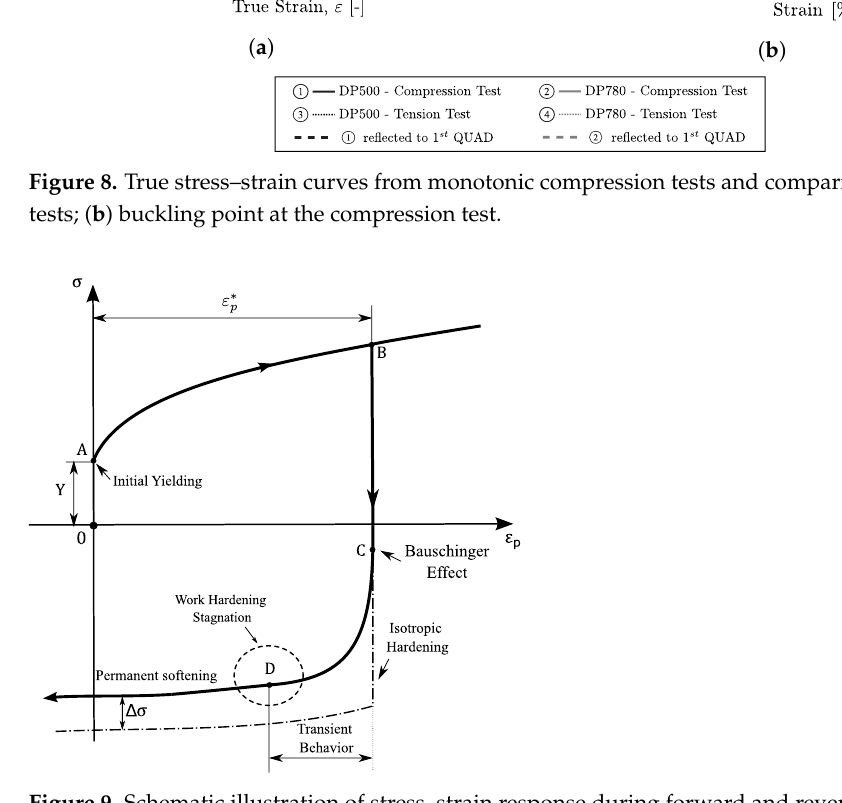
Figure 9. Schematic illustration of stress–strain response during forward and reverse